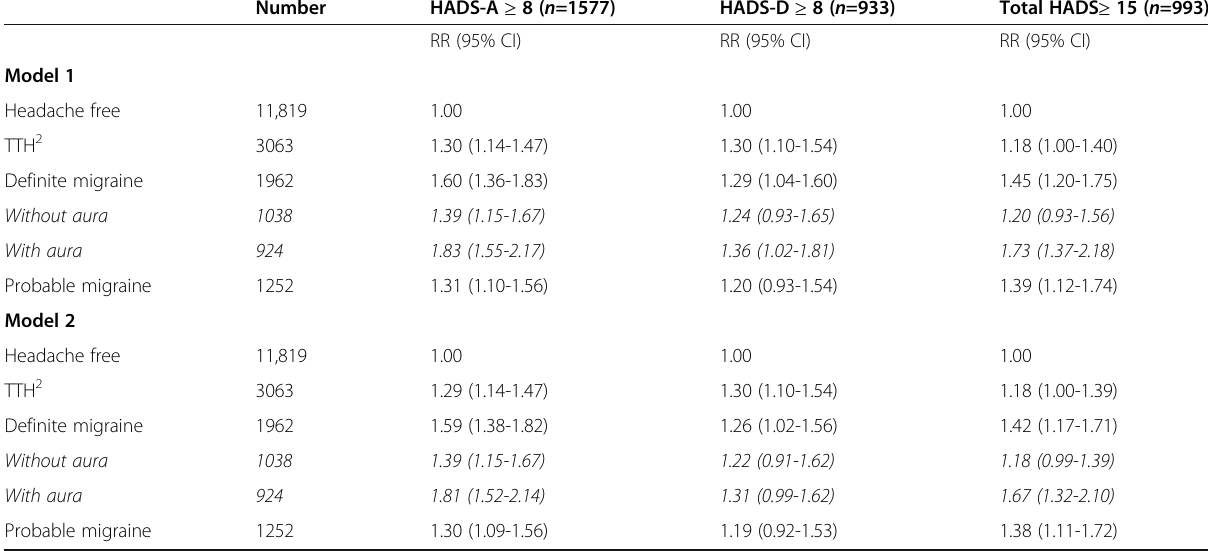
Table 4 HADS 1 anxiety and depression score ≤ 7 in HUNT3 ( n =18,380): Risk of elevated HADS 1 score in HUNT4 based on headache diagnoses in HUNT3 evaluated by poisson regression with 95% confidence